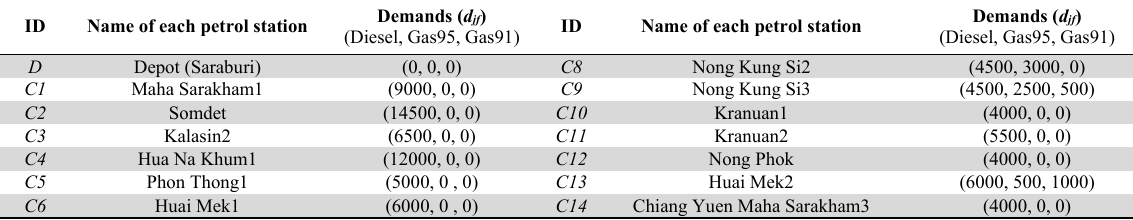
The demands for each fuel type of each petrol